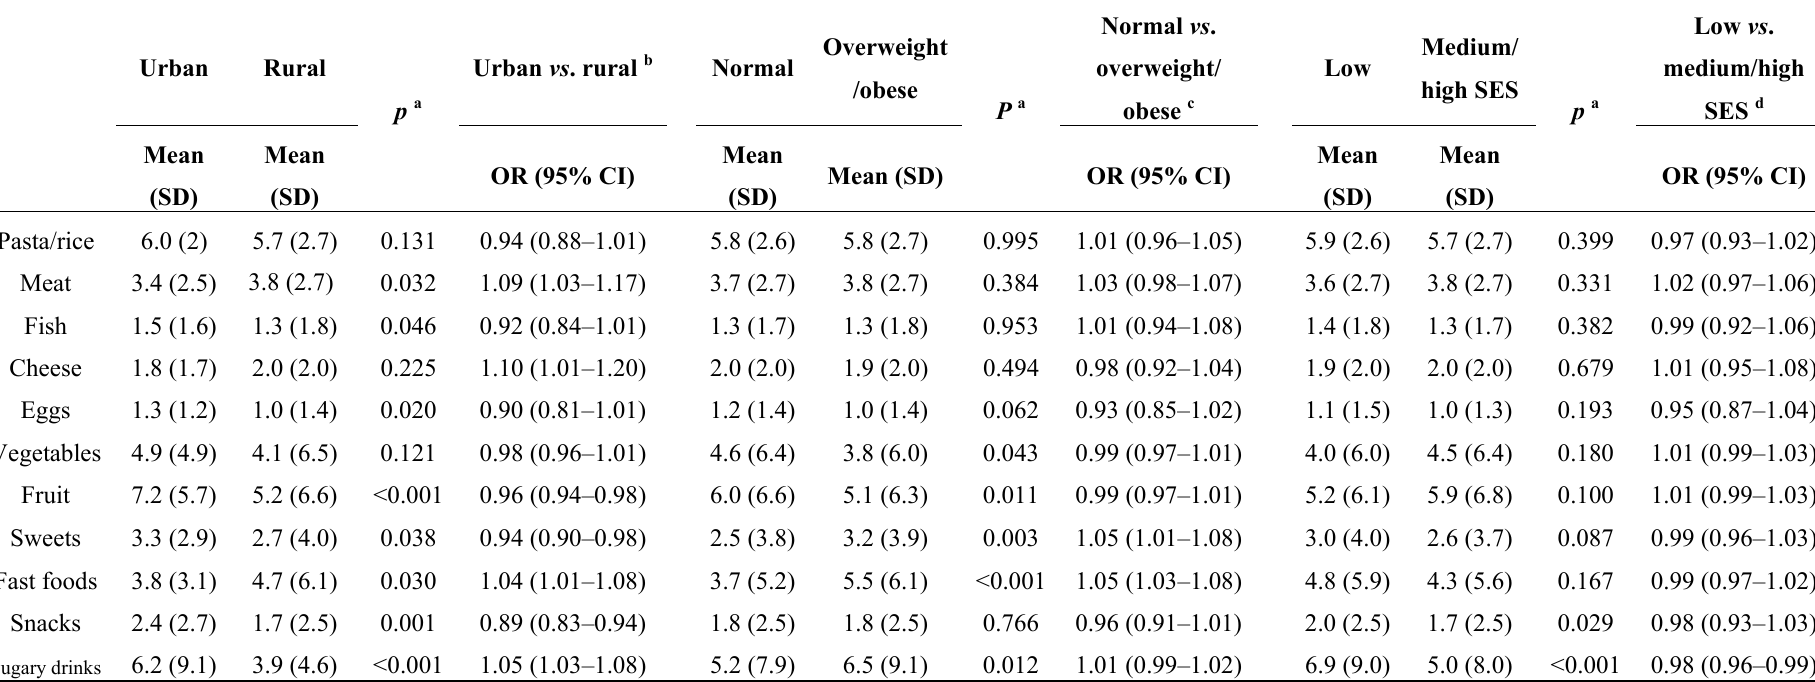
Table 5. Consumption (10 g/day) of food groups of the study population by place of living (rural vs . urban), BMI status (normal vs . overweight/obese), and socioeconomic status (low vs . medium/high) and relative odd ratios by multiple logistic regression analysis (first category as